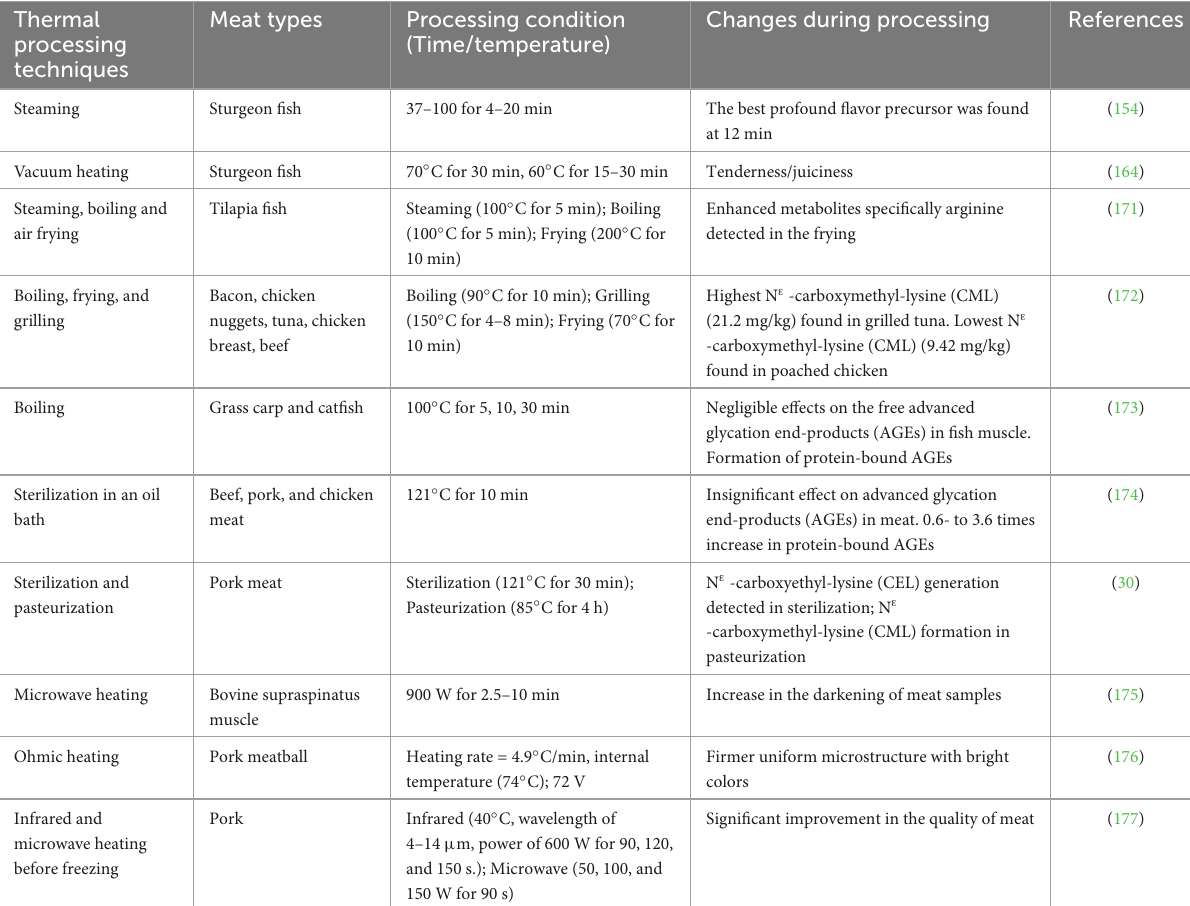
TABLE 2 Changes during various thermal processing techniques in various types of